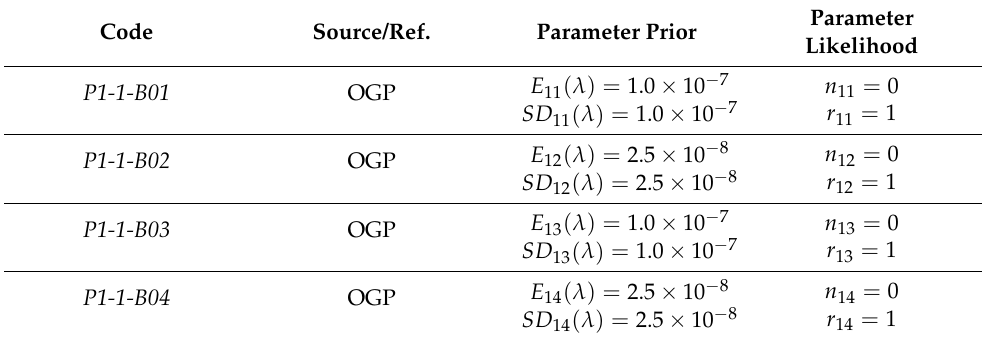
Table A3. Assigned parameters of BE for FT2. Code Source/Ref. Parameter Prior